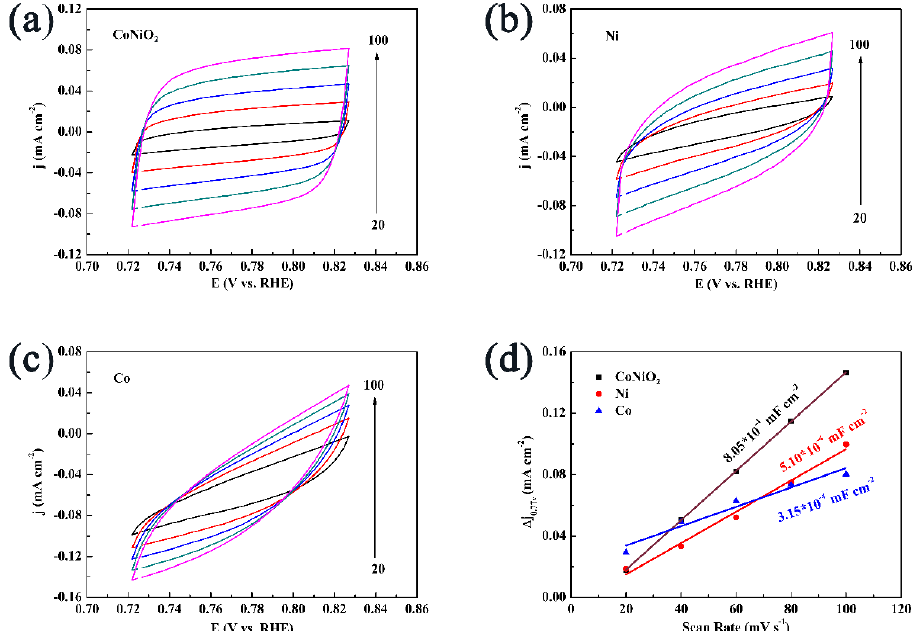
Figure 7. The CV curves of ( a ) CoNiO 2 , ( b ) metallic Ni and ( c ) metallic Co. ( d ) The double − layer capacitance values CoNiO 2 , metallic Ni and metallic Co in 1 M KOH.